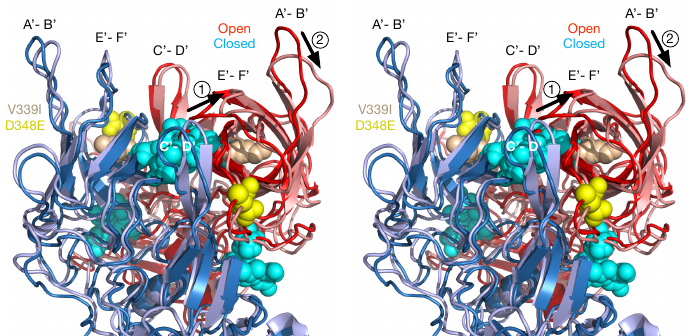
Figure 7. Dynamic simulations of the natural escape mutation to 2D3, V339I. Since V339I blocks 2D3 binding but is very distal to the antibody binding site, dynamic simulation calculations were performed to see the effects of V339I on the structure of the P domain dimer. The open conformation is red and the closed is blue with the darker hues representing the initial structure before the simulations. The location of V339I is shown in tan and the other escape mutant, D348E, in yellow. Compared to simulations on the wild type P domain structure, several notable changes were observed. There were disruptions in the hydrogen bonds between the dimers (cyan spheres) and the A’-B’ and E’-F’ loops in the open conformation started to approach that of the closed conformation. Figure adapted from